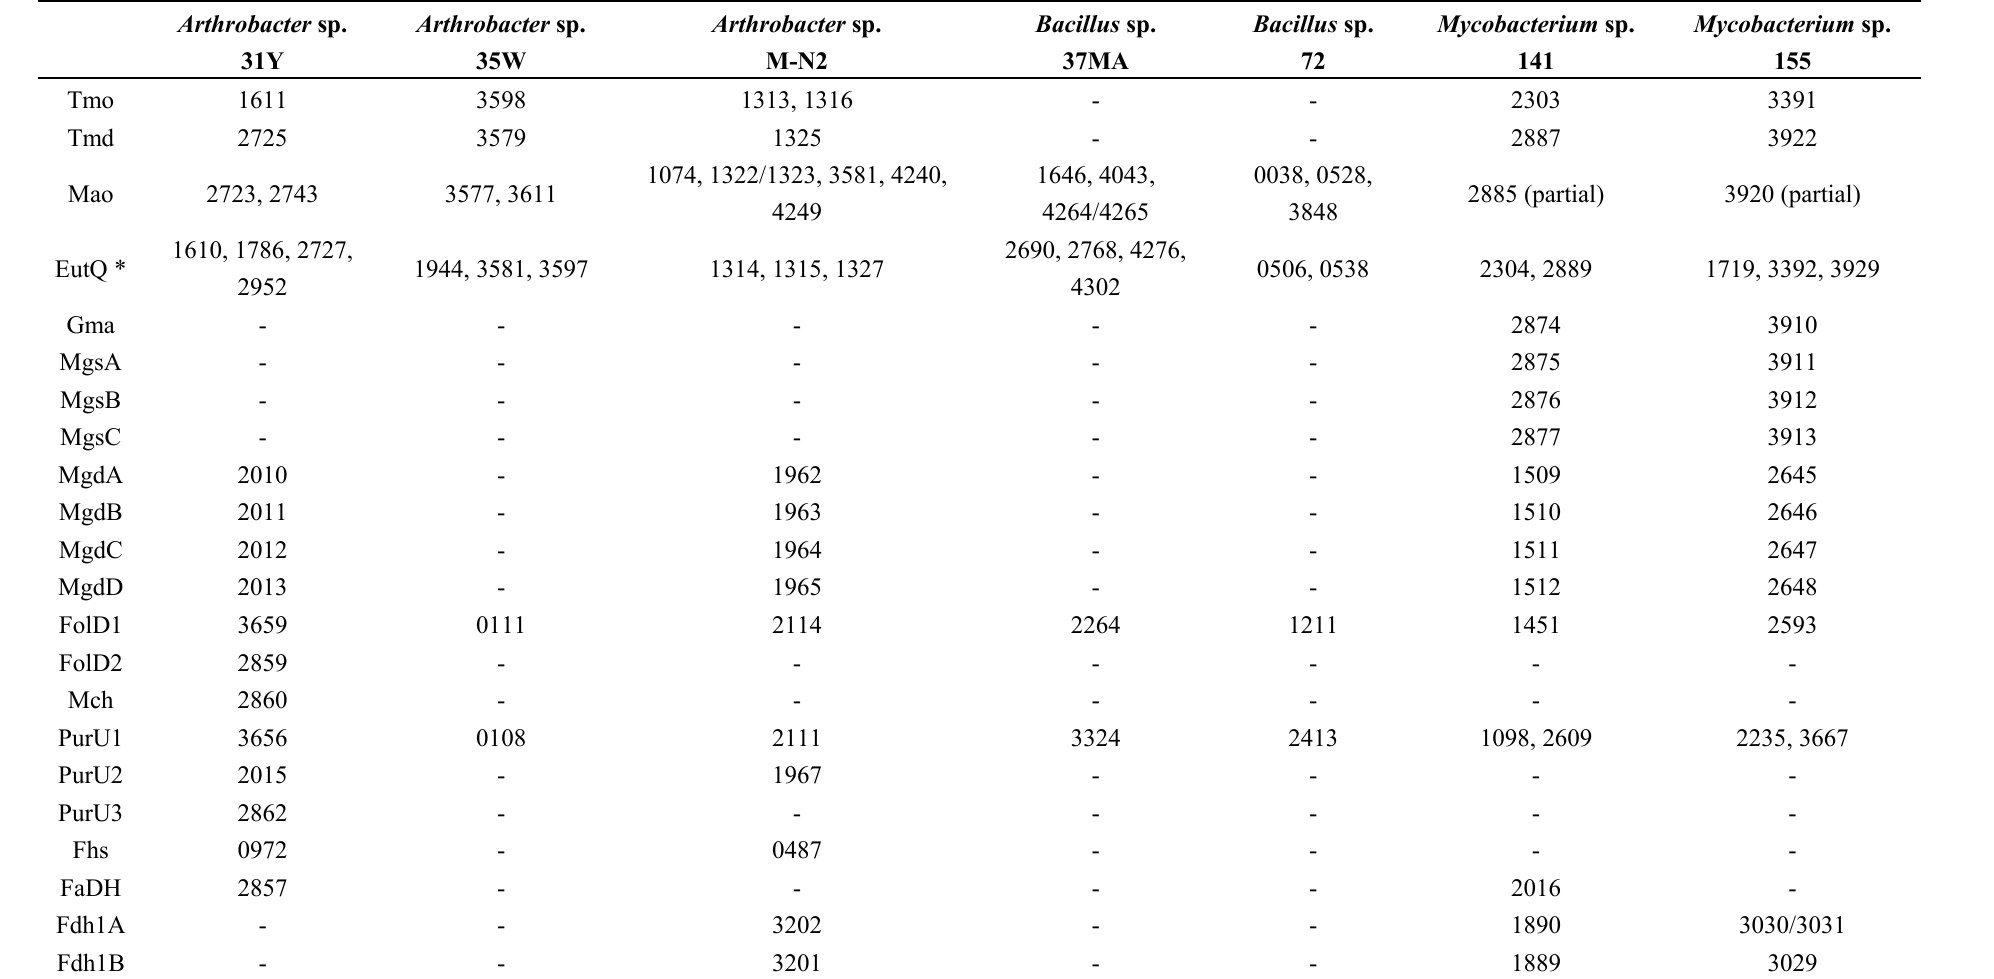
Table 2. Enzymes involved in